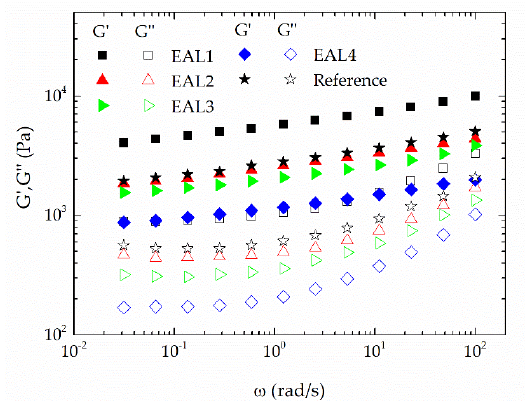
Figure 4. Evolution of the storage ( G ′ ) and loss ( G ″ ) moduli with frequency for epoxidized lignin-based oleogel as a function of lignin epoxy index (5 wt % EAL). Star symbols correspond to the reference system prepared with non-epoxidized lignin and NaOH in the same proportion than sample EAL1. ( G ′, filled symbols; G ″ , empty symbols).